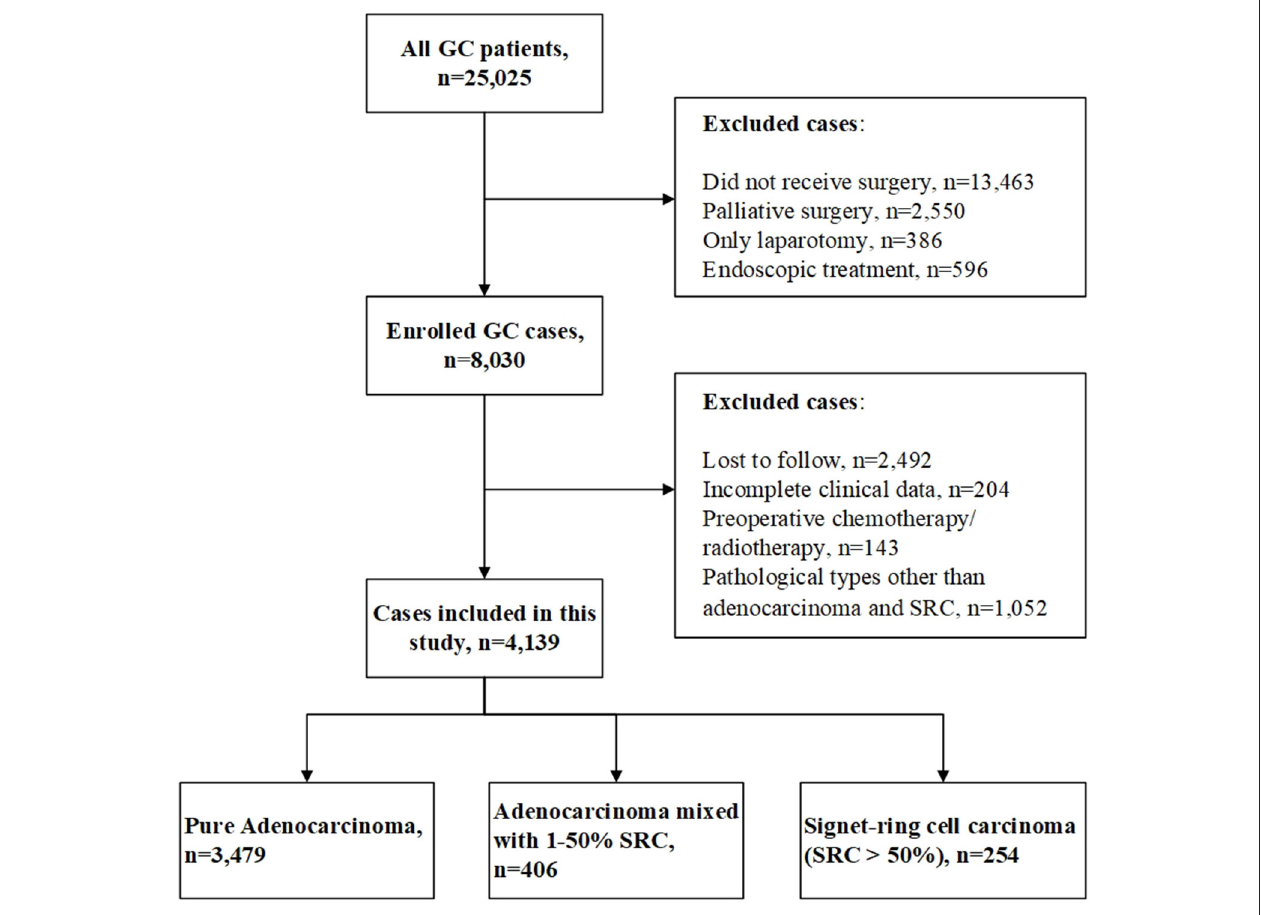
FIGURE 1 | Flowchart of patients’ selection process (GC, gastric cancer; SRC, signet ring